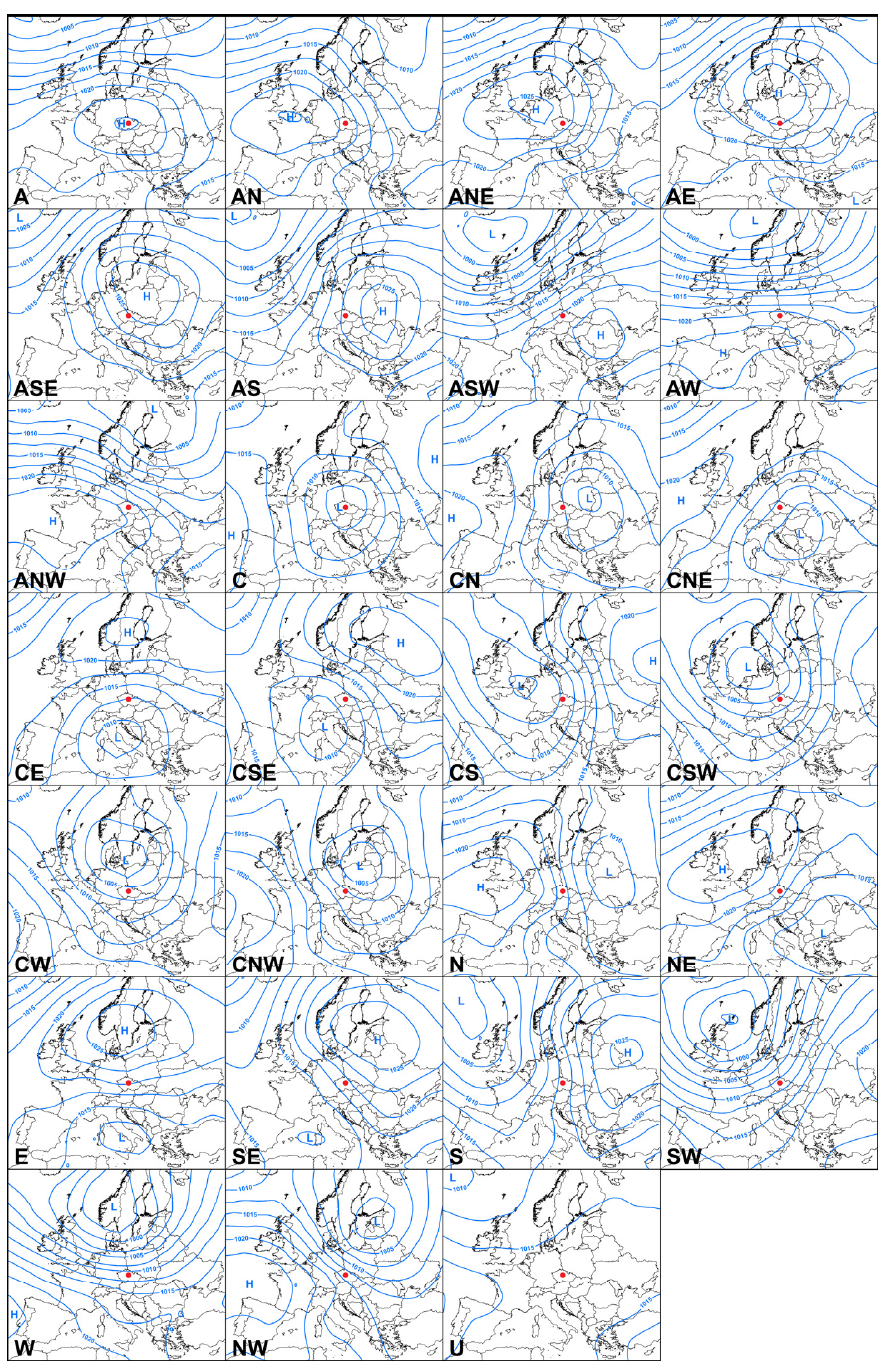
Figure A2. Mean SLP fields for the 27 objectively derived circulation types (centered on the geographic midpoint of the Czech Republic—red point) created for the 1961–2020 period. Types: A, centered anticyclone; AN, anticyclonic northern; ANE, anticyclonic northeastern; AE, anticyclonic eastern; ASE, anticyclonic southeastern; AS, anticyclonic southern; ASW, anticyclonic southwestern; AW, anticyclonic western; ANW, anticyclonic northwestern; C, centered cyclone; CN, cyclonic northern; CNE, cyclonic northeastern; CE, cyclonic eastern; CSE, cyclonic southeastern; CS, cyclonic southern; CSW, cyclonic southwestern; CW, cyclonic western; CNW, cyclonic northwestern; N, directional northern; NE, directional northeastern; E, directional eastern; SE, directional southeastern; S, directional southern; SW, directional southwestern; W, directional western; NW, directional northwestern; U, unclassified.